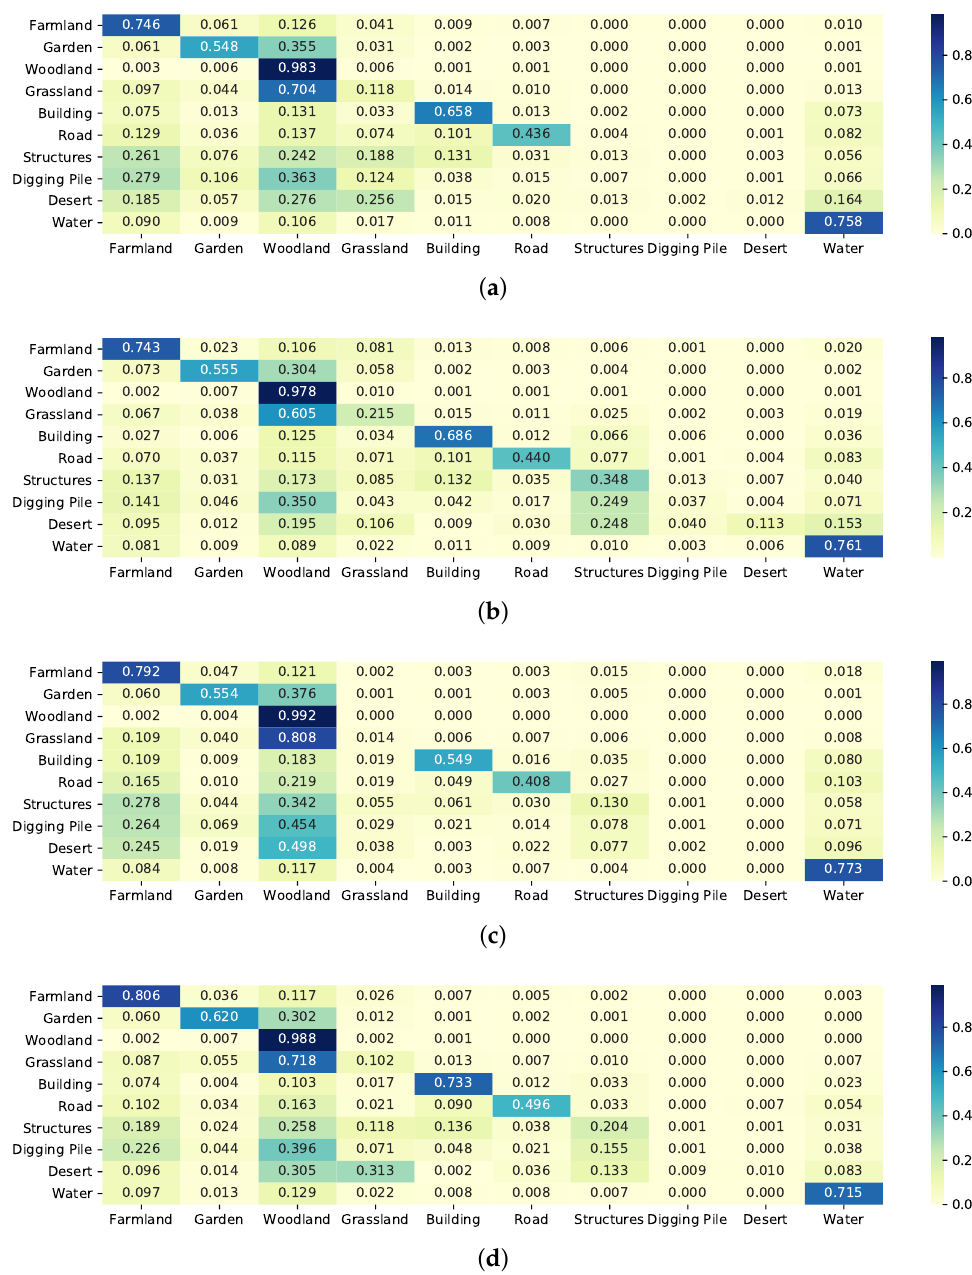
Figure 15. Confusion matrices on the Songxi dataset. ( a ) FCN-8s; ( b ) PSPNet; ( c ) SDFCN V1; ( d )